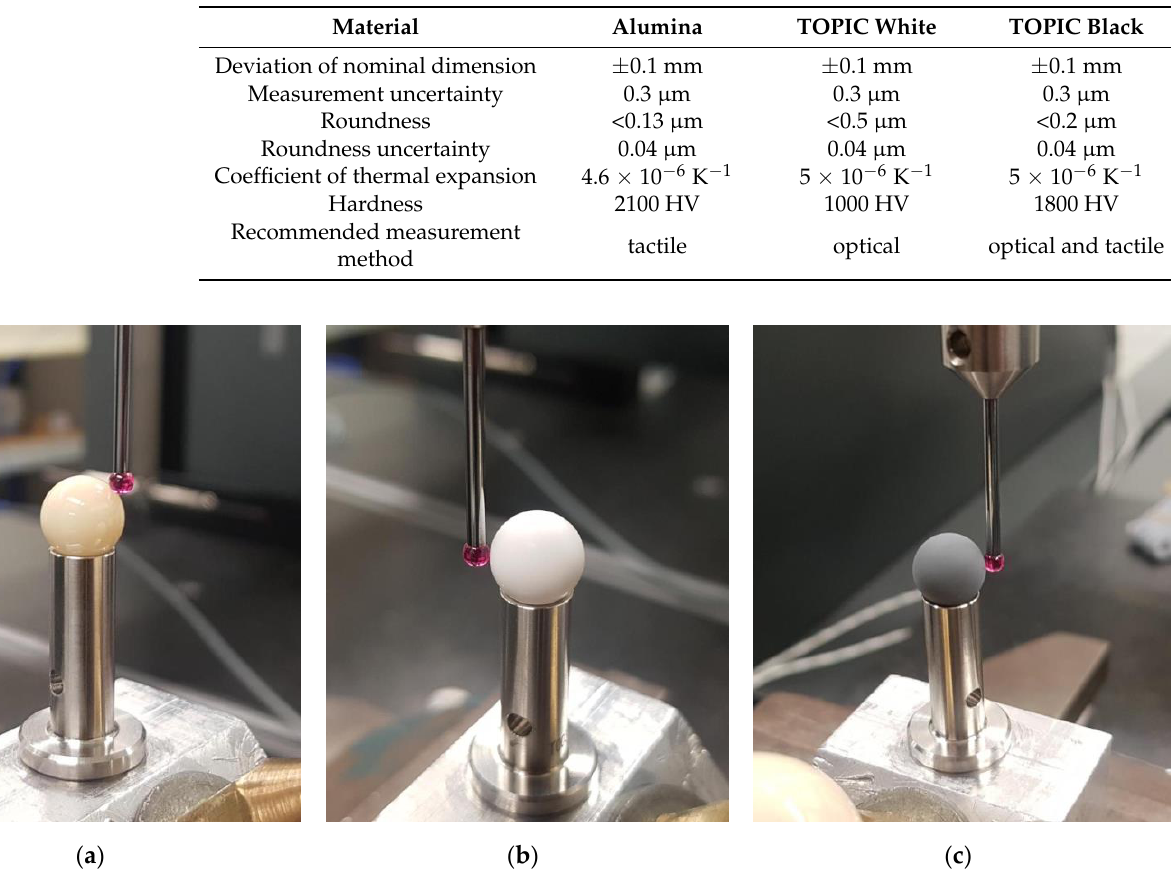
Table 1. Characteristics of the calibration spheres.